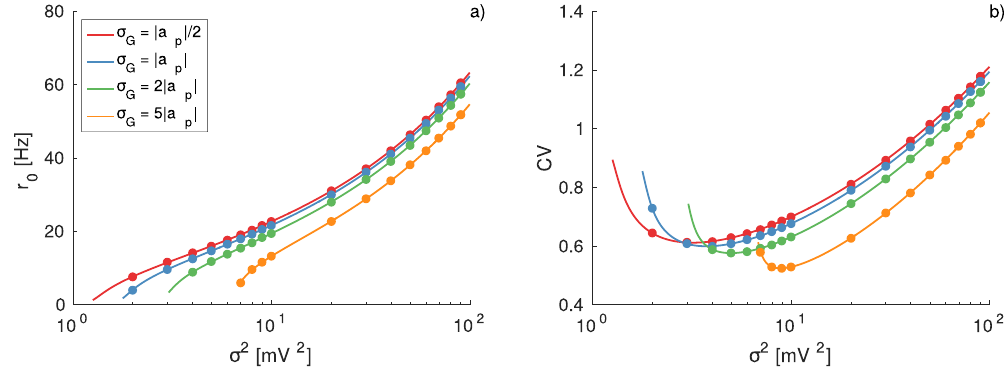
Figure 4. Effect of the distribution asymmetry on the firing time statistics. ( a ) Average firing rate r 0 as a function of the noise intensity for different values of the standard deviation of the Gaussian distribution σ G as indicated in the legend. ( b ) Coefficient of variation CV for the same cases depicted in ( a ). The reported data refer to TGDs with the peak located at | a p | = 1 mV and to an effective input μ T = 9 mV. Symbols correspond to numerical simulations, and the solid lines to the theoretical results reported in Eq. (17) and Eq. (27). Other parameters and simulation procedures as in Fig. 1